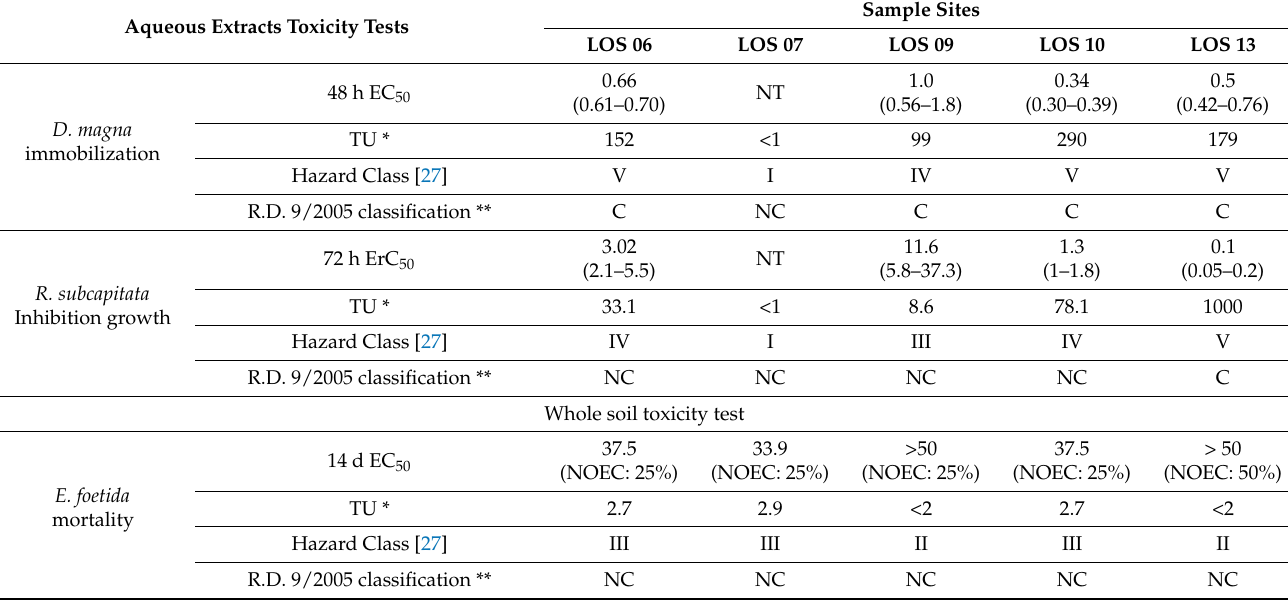
Table 4. 48 h EC 50 for D. magna assays and 72 h ErC 50 for R. subcapitata assays (95% confidence intervals) expressed as percentage of water extract in test medium ( v / v ). 14 d EC 50 in E. foetida assays expressed as percentage of dw soil in medium ( w / w